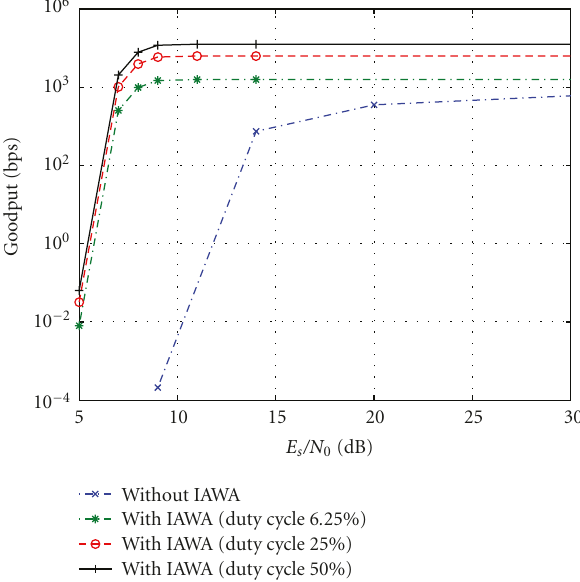
Figure 11: Goodput of the IEEE 802.15.4 link using the IAWA coexistence mechanism with di ff erent Duty Cycles. The distance between the interferer and the intended receiver is set to